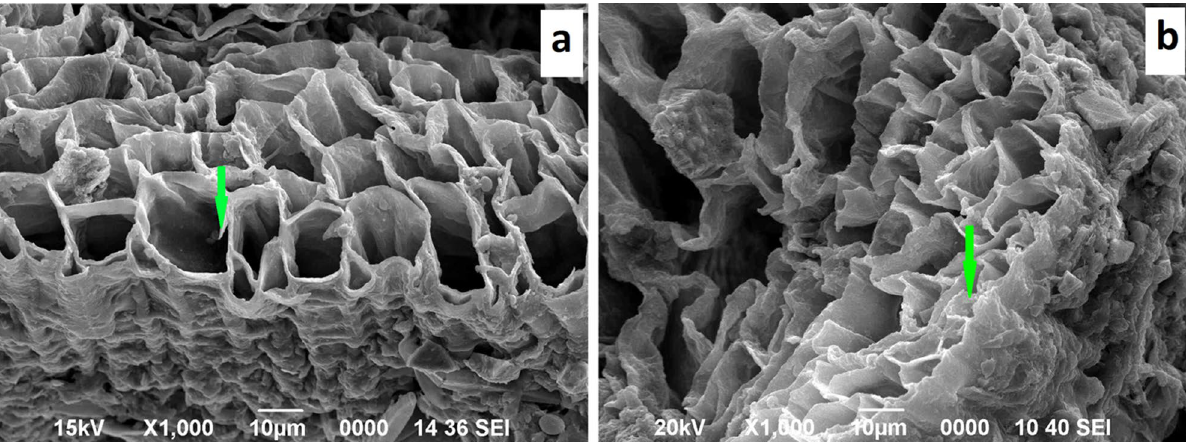
Figure 5. SEM micrographs of transverse section of T. natans root: ( a ) control root, ( b ) Sb treated root showing changes in shape of parenchyma